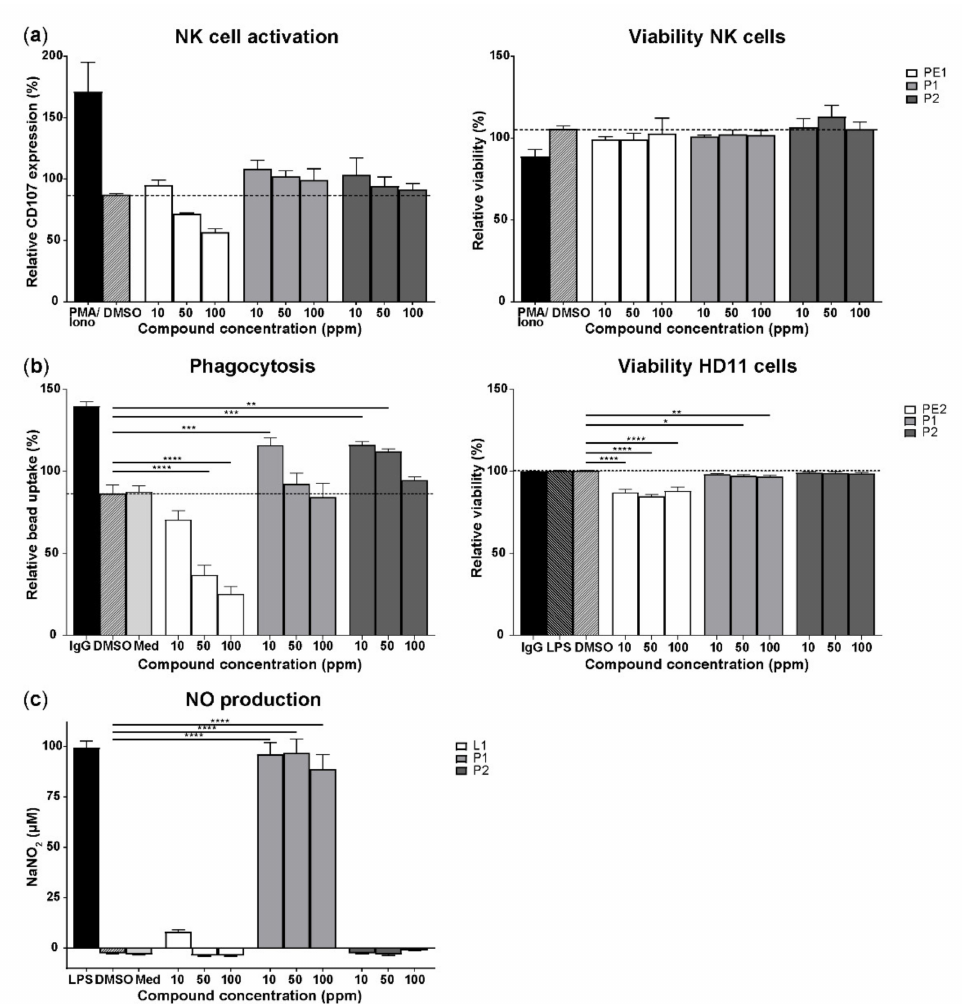
Figure 1. In vitro screening of feed compounds for their effect on the activation of NK cells and macrophages. ( a ) The effect of compounds on NK cell activation measured by the CD107 expression on NK cells (%). Expression of CD107 is expressed relative to the negative control, which was set at 100% (left panel). Viability of ED14 NK cells after exposure to compounds, which is expressed relative to the negative control set at 100% (right panel). PMA/Ionomycin was included as the positive control, 1:5 DMSO as the solvent control, and n = 3 per compound concentration. ( b ) The effect of compounds on the phagocytosis of macrophage-like HD11 cells (%). Phagocytosis is expressed relative to the reference control, which was set at 100% (left panel). Viability of HD11 cells after exposure to compounds, which is expressed relative to the negative control set at 100% (right panel). IgY-coated beads are included as positive control to determine the highest level of phagocytosis, LPS- coated beads in 1:5 DMSO as the solvent control, and uncoupled beads in complete RPMI medium as the negative control to determine baseline phagocytosis, n = 3 per compound concentration. ( c ) The effect of compounds on the NO production of macrophage-like HD11 cells by measuring nitrite concentration ( µ M). LPS stimulation was included as the positive control, 1:5 DMSO as the solvent control, complete RPMI medium as the negative control, and all samples were in triplicates, n = 9 per compound concentration. Mean + SEM is shown of the compounds of polysaccharides (P1, P2), plant extracts (PE1, PE2), and lipids (L1); the dotted line represents the level of the solvent control and statistical significance is indicated as * p < 0.05, ** p < 0.01, *** p < 0.001, and **** p <